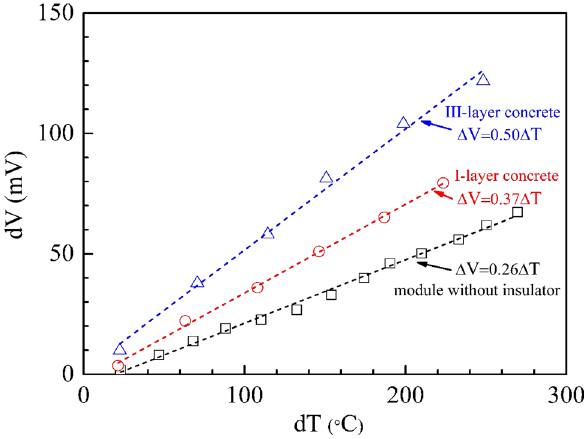
Figure 10. Output voltage as a function of temperature difference obtained in the open circuit